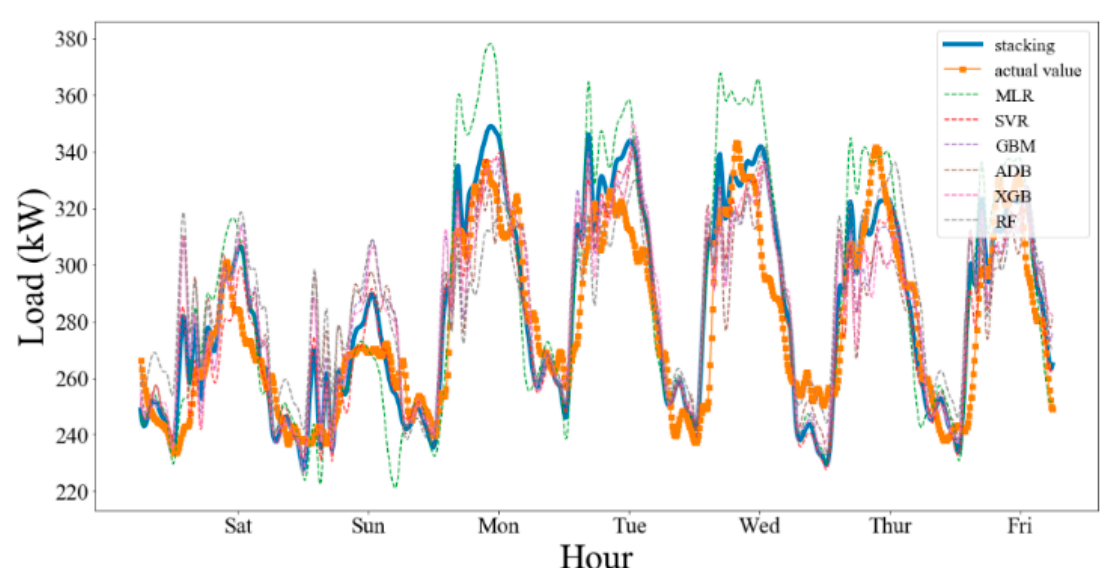
Figure 8. Examples of load forecasts for a certain week produced by the first layer models and the stacking ensemble learning model.